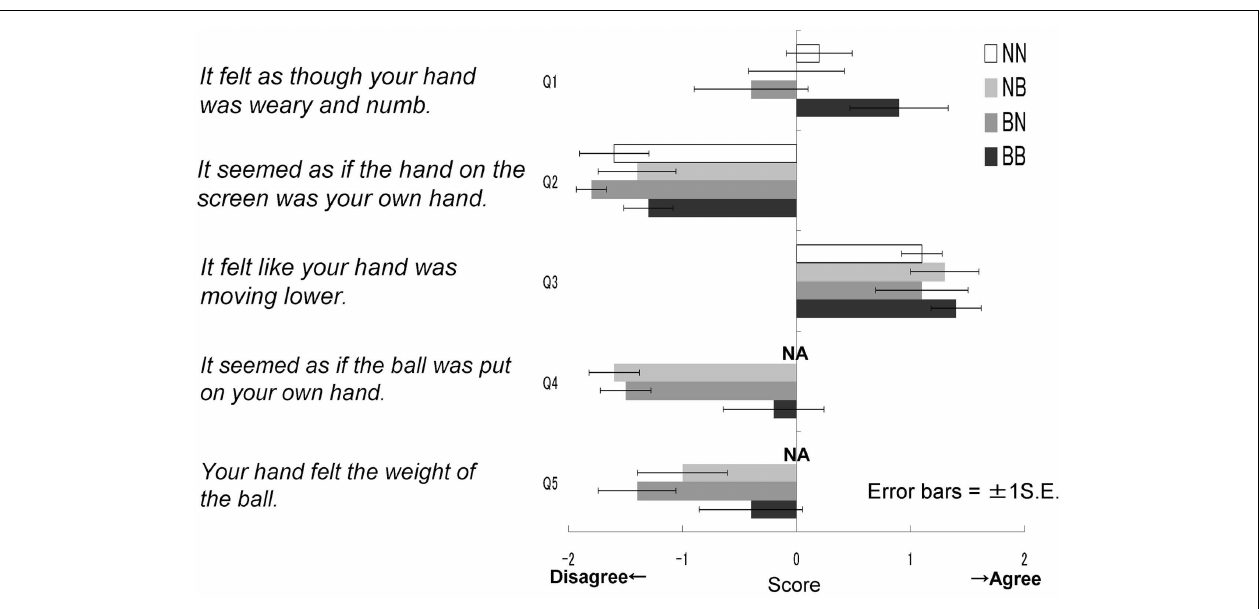
screen was your own hand. It felt like your hand was moving lower. It seemed as if the ball was put on your own hand.Your hand felt the weight of the